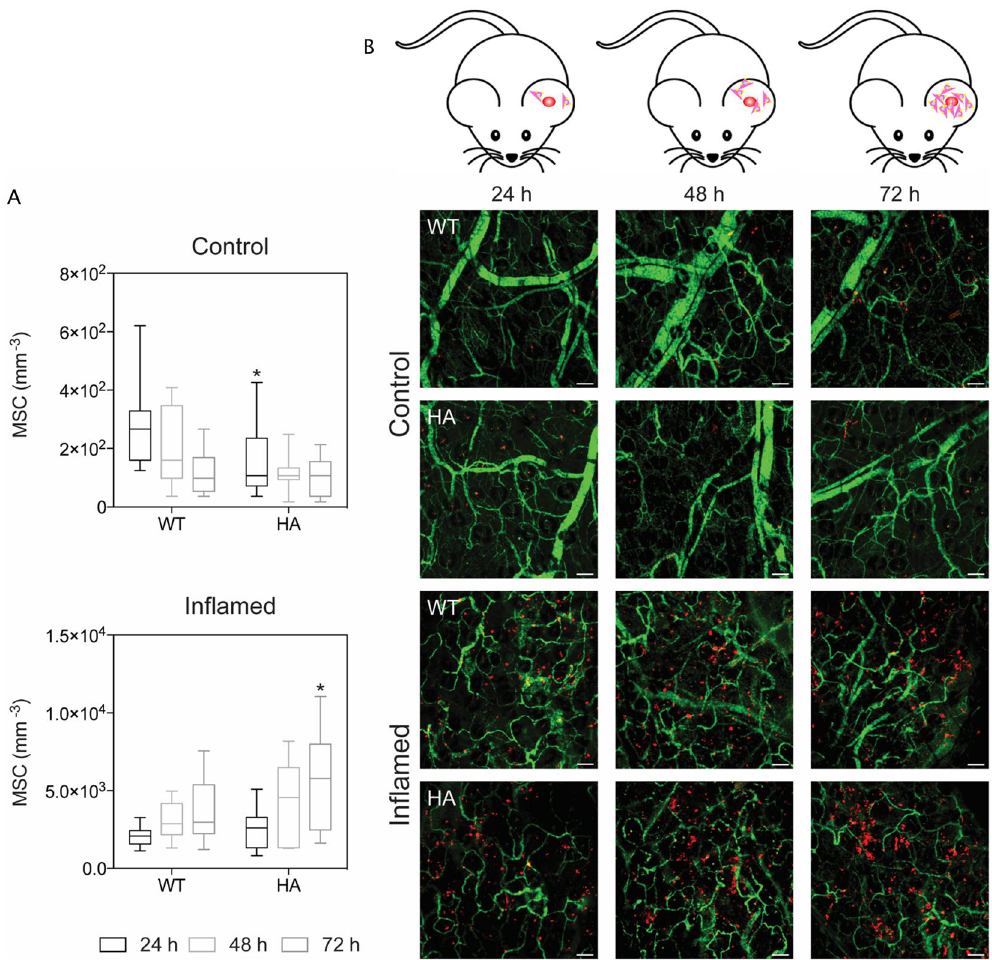
Figure 5. In vivo migration of MSC towards the inflammatory site. Representative maximum intensity projection images of control (top) and inflamed (bottom) ears at 24, 48, and 72 hrs after systemic administration of MSC ( A ). Vessels are shown in green and MSC in red. Scale bar: 100 µ m. * p-value < 0.05. Quantification of MSC that successfully homed to control (top) or inflamed (bottom) ears (B) . Graphs are shown as box plots with the whiskers showing the minimum and maximum data points in each